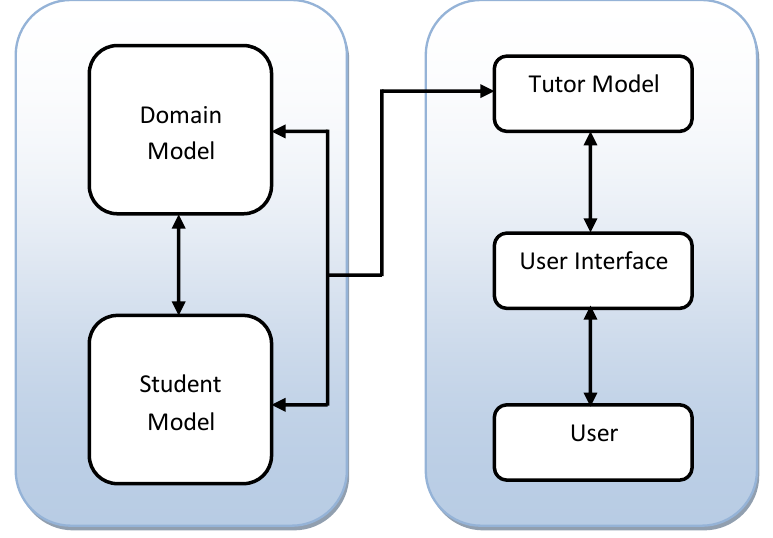
Figure 1. Architecture of an ITS.